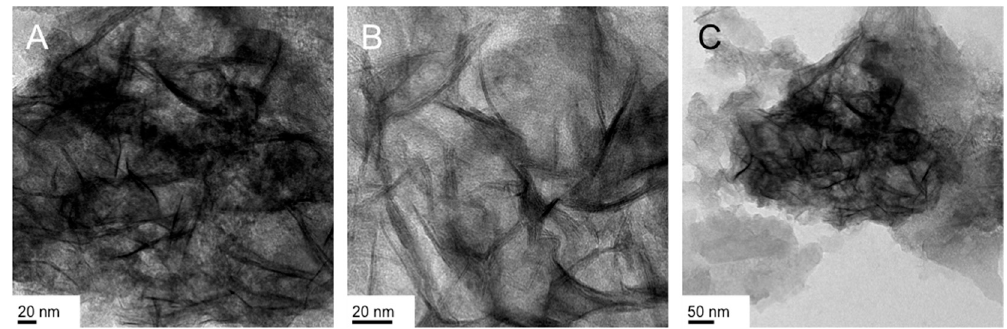
Figure 4. TEM images of the IO nanostructures obtained in the L α phase of Triton X-100 in water (70 wt % Triton X-100): the reaction was performed at 3 °C and both gel and froth fraction contain the same product (see images in ( A – C )).